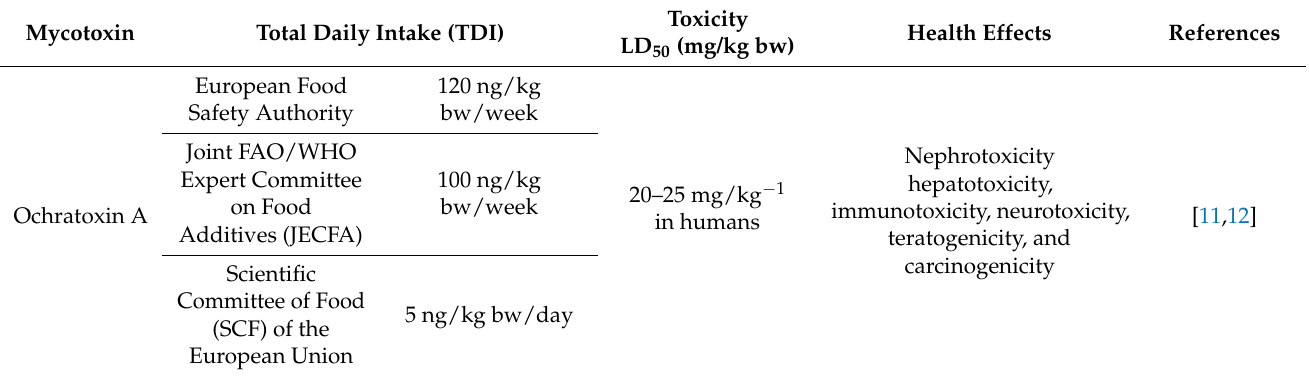
Table 1. Total daily intake for mycotoxins and median lethal